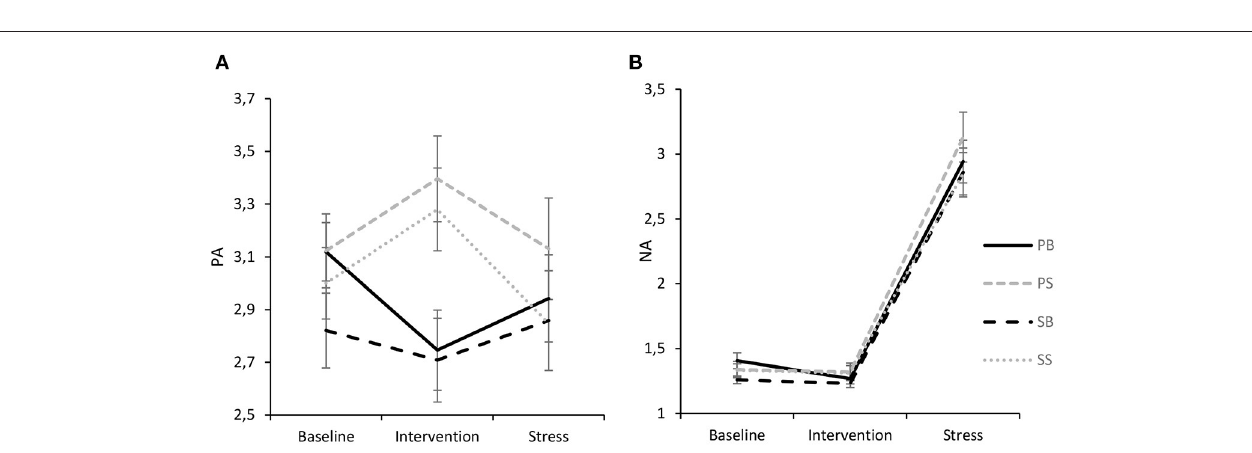
FIGURE 5 | Interaction of experimental intervention and time (M ± 1 SE) for PA (A) and NA (B) . PB, paced breathing at 0.1Hz; PS, paced singing at 0.1Hz; SB, spontaneous breathing; SS, spontaneous singing. It is shown that both singing interventions increased PA, while paced breathing led to a deterioration of PA. NA only evidenced a pronounced stress